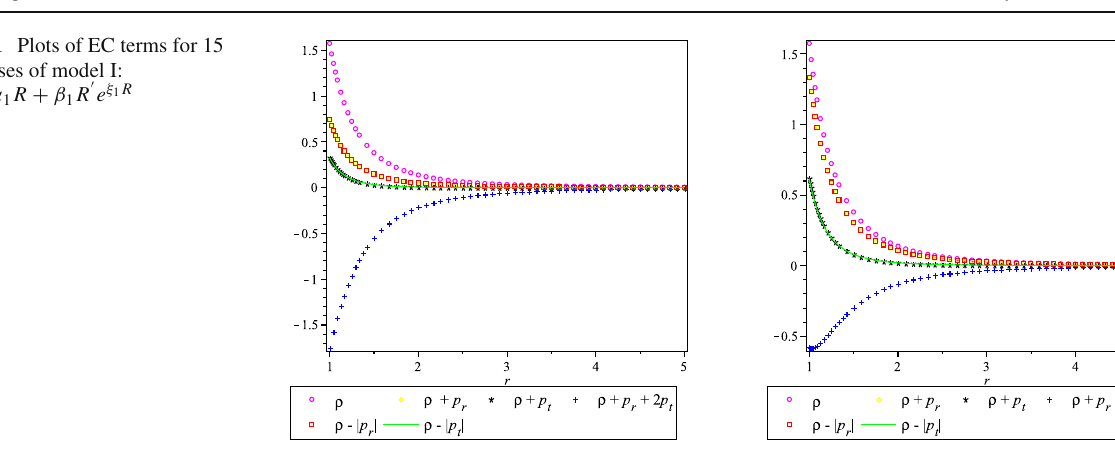
( a ) This figure depicts the behavior of all EC terms for Model-I in Subcase 1 ( ξ 1 = 0, α 1 > 0, β 1 > 0, α > 0). NEC, WEC and DEC are found to be satisfied for every r > 0.